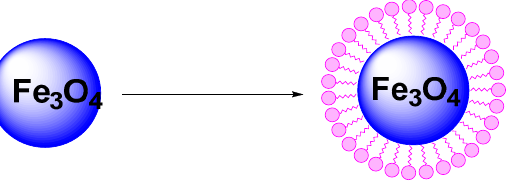
Figure 2. Functionalization of IONP with multipotent antioxidants.